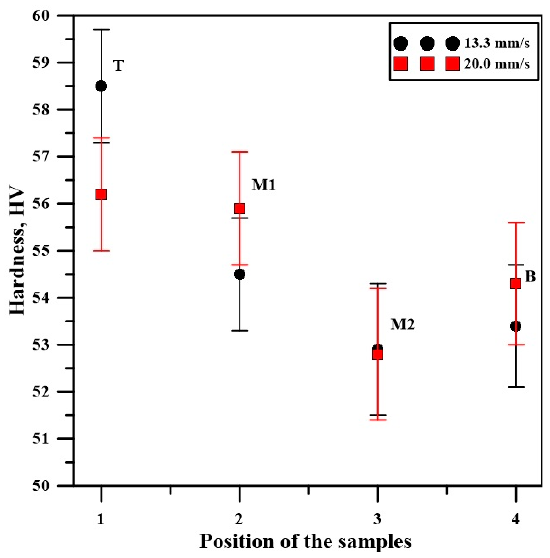
Figure 10. Vickers hardness of the samples taken from both specimens.